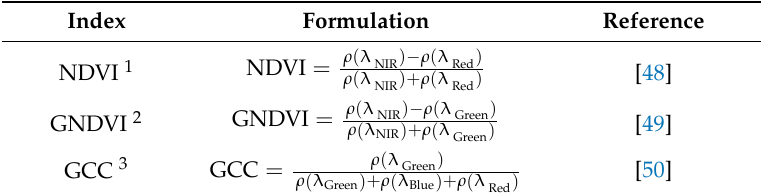
Table 2. Formulation of satellite-based vegetation indices used in this